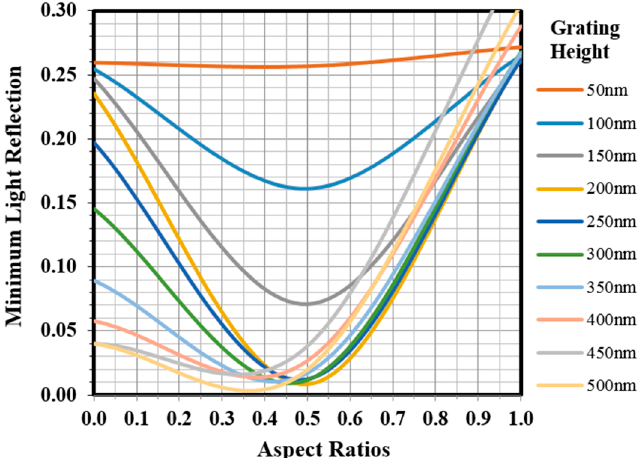
Figure 10. Minimum light reflection versus the aspect ratios for different nano ‐ grating heights with the grating period or pitch of 830 ‐ nm. Here, the nano ‐ grating height is varied from 50 nm to 500 nm.